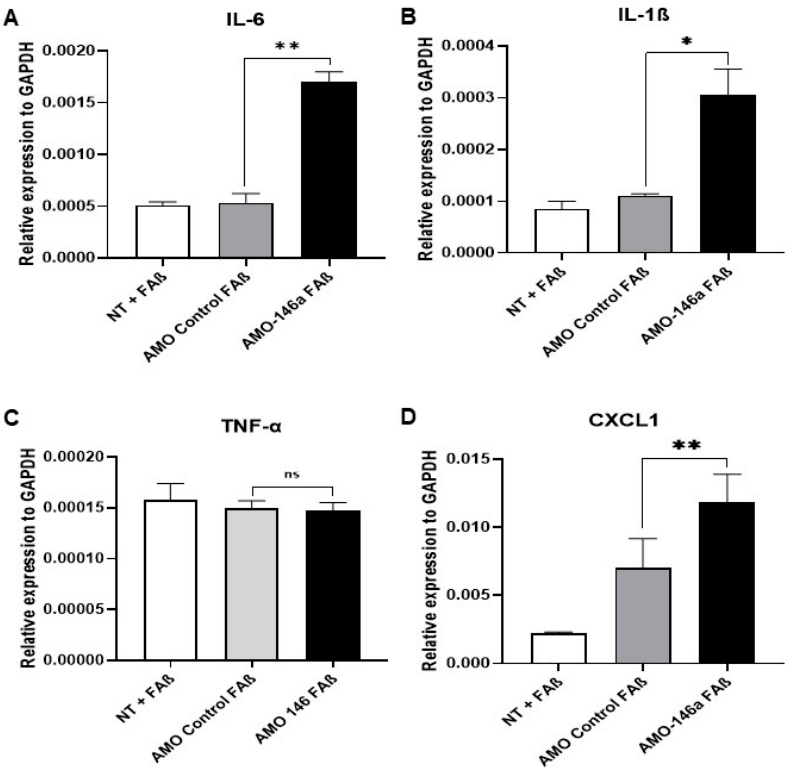
Figure 11. Transfection of miRNA-146-5p inhibitor in FA β 1-42 -treated astrocytes rescues as well promote the expression of pro-inflammatory molecules. Astrocytes were first transfected with AMO-146a or AMO-CTL (100 nM), then treated with FA β 1–42 peptides (2 µ M) before quantification relative of the expression of ( A ) IL-6, ( B ) IL-1 β , ( C ) TNF- α , and ( D ) CXCL1 by qRT-PCR. Data are represented as mean ± SEM of one representative experiment performed twice in triplicate. Statistical comparisons between groups were made using a Student’s t -test. * p ≤ 0.05 , ** p ≤ 0.01.